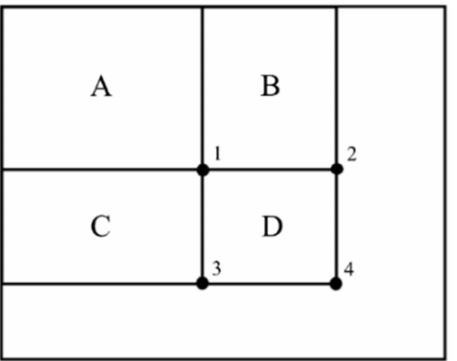
Figure 4. The eigenvalue of area of Viola–Jones algorithm. A to D is the eigenvalue area, and 1 to 4 mean the